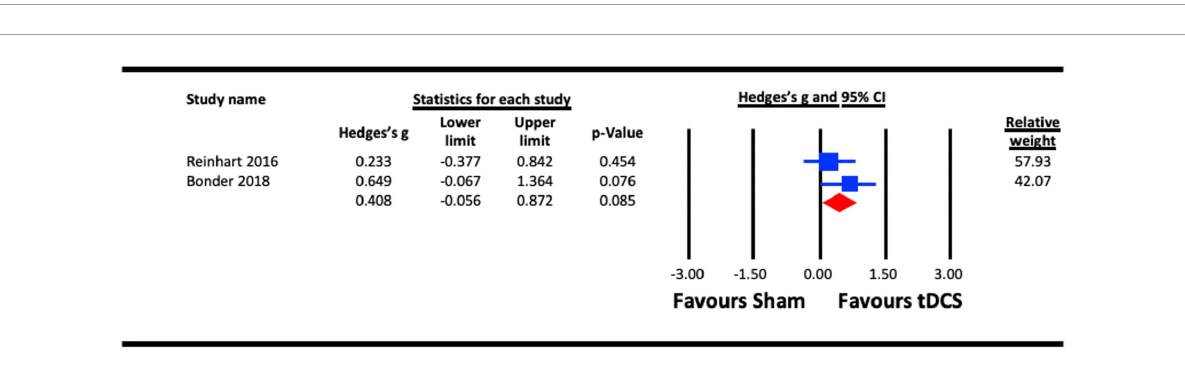
FIGURE8 Acute effect of anodal-transcranial direct current stimulation (a-tDCS) on visual acuity.